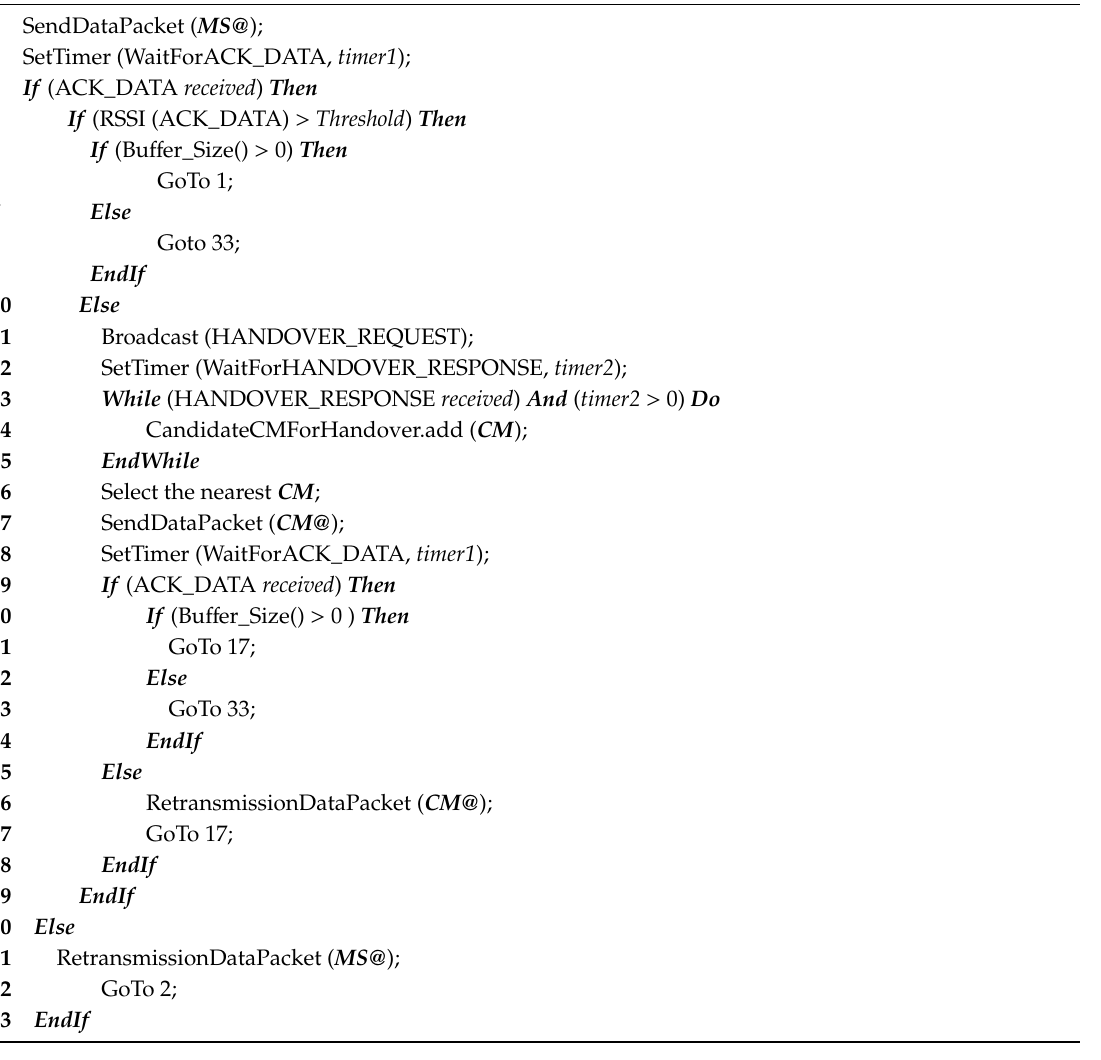
Algorithm 3 BMAC-H algorithm at CH for Cluster-Based Wireless Sensor